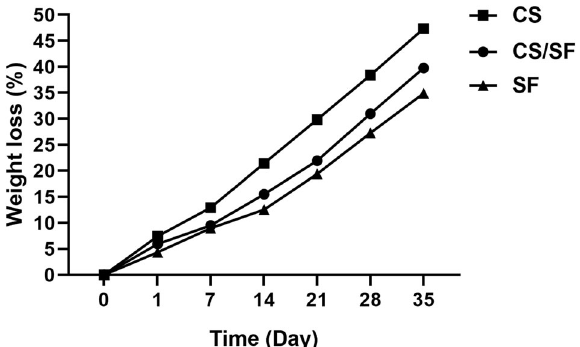
Fig. 3 The biodegradation rate of the scaffolds after 35 days. CS signi fi cantly degrades faster from day 1 to 35 compared to other samples in all time intervals ( P < 0.05). There are no signi fi cant dif- ferences between SF and CS/SF scaffolds during 21 days ( P > 0.05). CS/SF sample degrades signi fi cantly faster than SF alone from day 21 to 35 in all-time intervals ( P < 0.05)